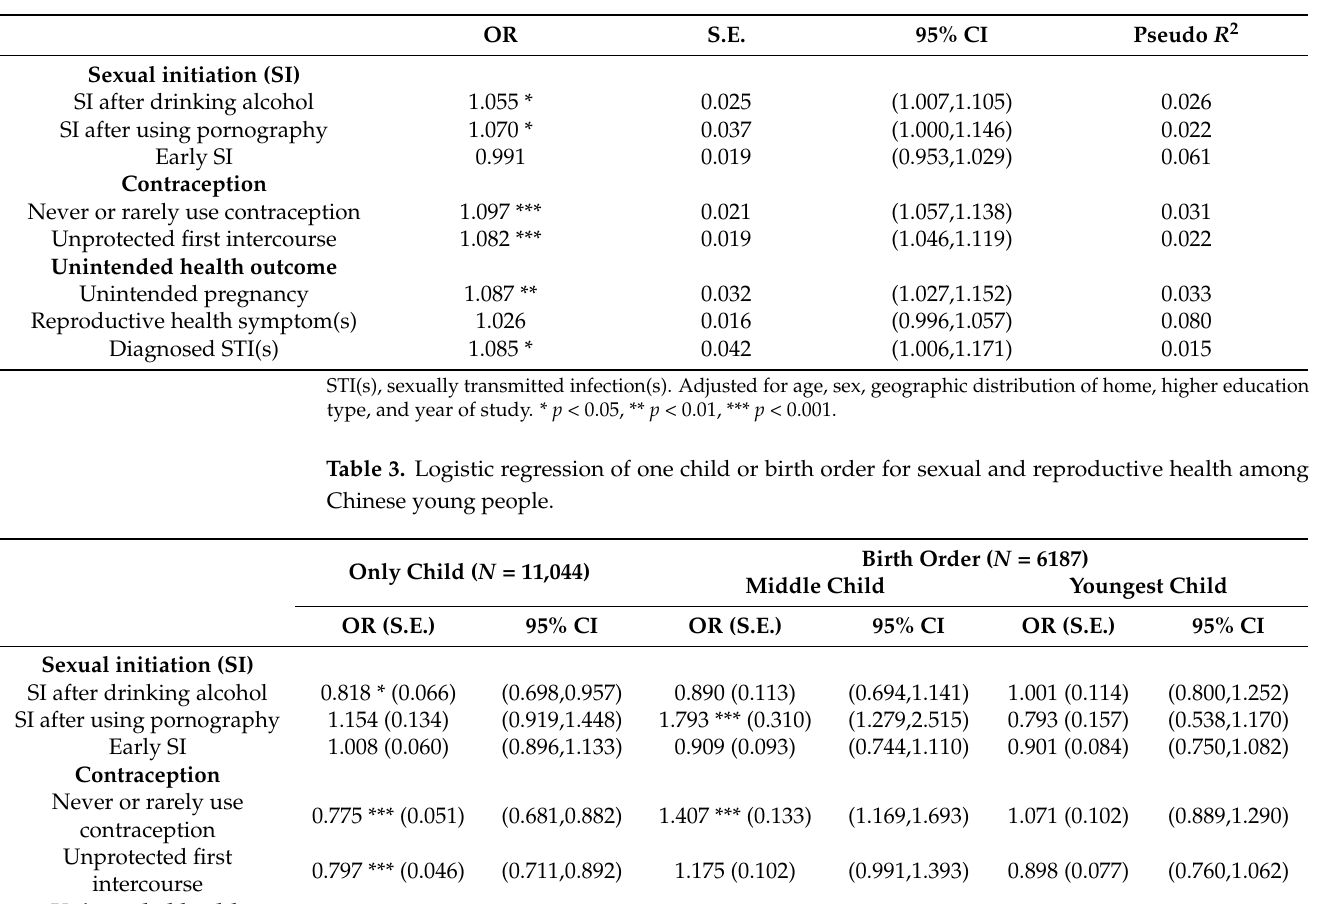
Table 2. Logistic regression of sibship size for sexual and reproductive health among Chinese young people ( N = 11,044).